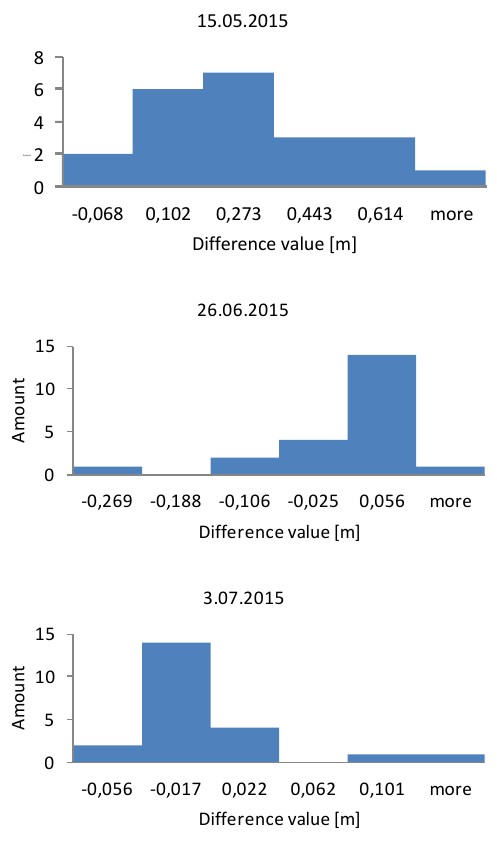
Figure 6. Histograms of calculated height